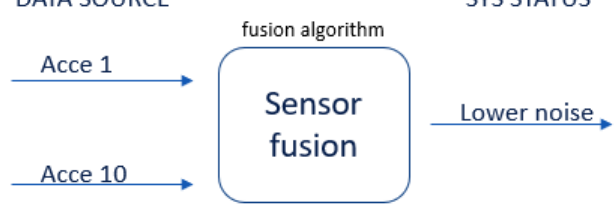
Figure 16. Fusion of data from identical sensors.